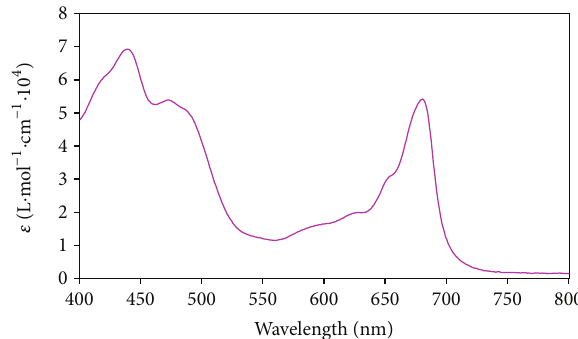
Figure 1: Spectrum of pigments molar extinction